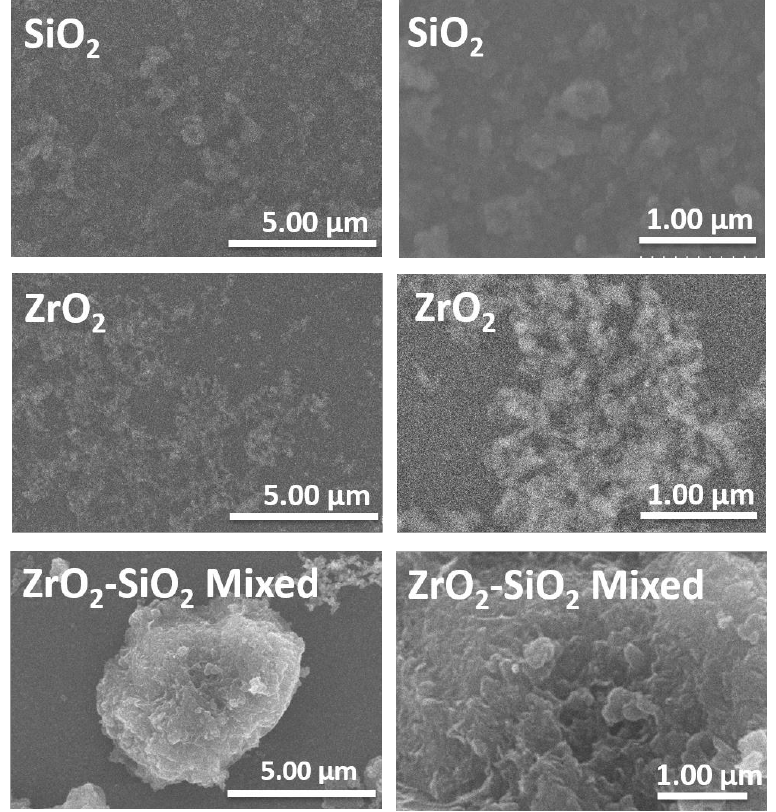
Figure 4. The SEM images of SiO 2 , ZrO 2, and ZrO 2 -SiO 2 mixed fillers.